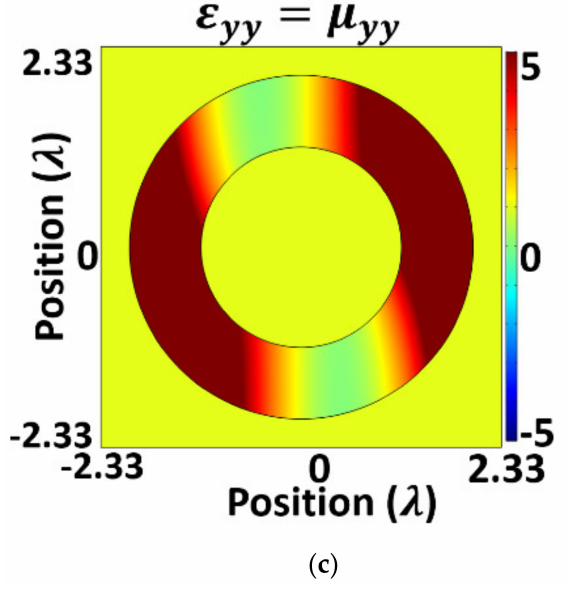
Figure 4. Spatial variation of material parameters inside the TO-based rotator shell, ( a ) xx- components, ( b ) xy- and yx- components, and ( c ) yy-components. The dimensions of the rotator are given by R 1 = 1.17 λ and R 2 = 2 λ . The material parameter s ε xy , µ xy , ε yx , and µ yx are